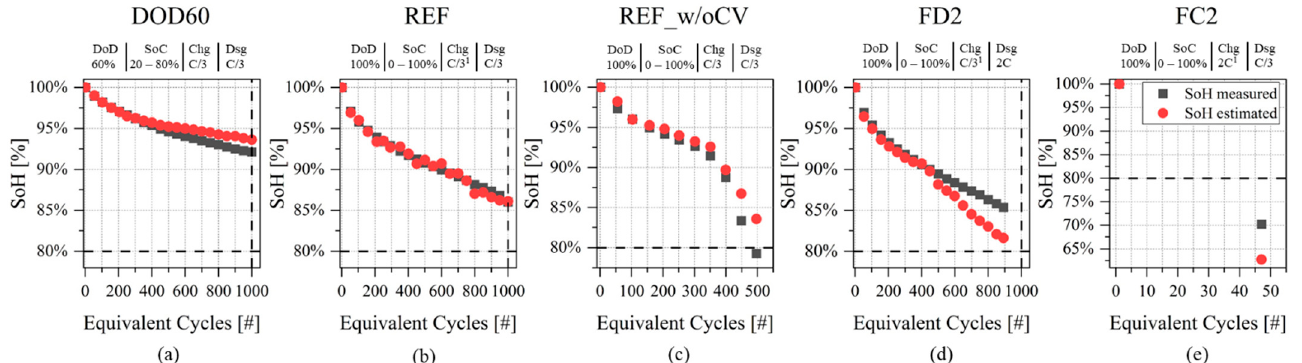
Figure 9. ( a ) SoH functions found with the training cells in Table 3; and ( b ) fitting coefficients (SoH model described in Equation (6)).